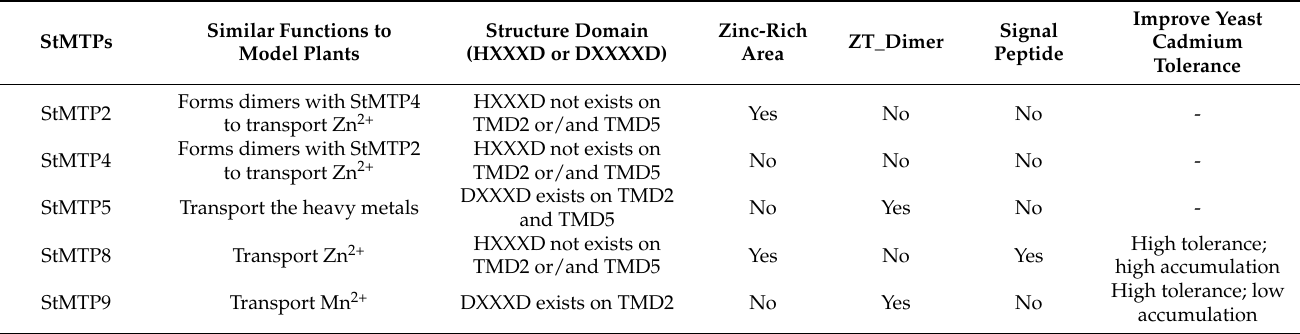
Table 2. Summary of the functional